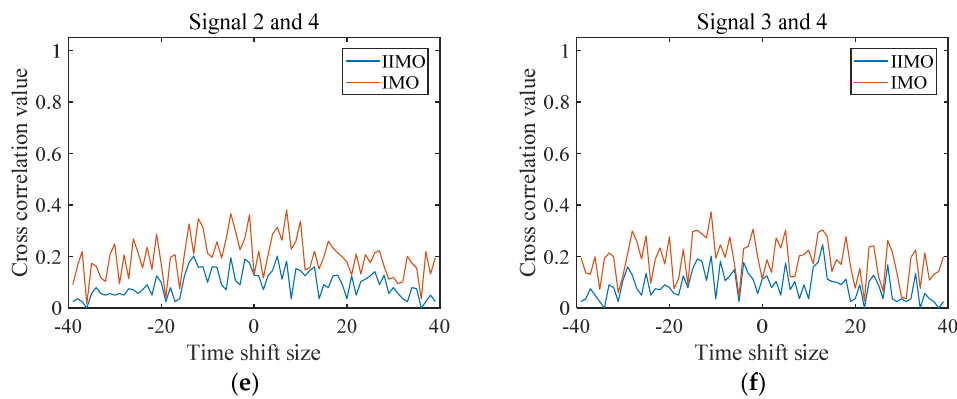
Figure 4. Cross-correlation values of polyphase codes obtained by IMO and IIMO under L = 4 and N = 40 on ( a ) between signal 1 and 2, ( b ) between signal 1 and 3, ( c ) between signal 1 and 4, ( d ) between signal 2 and 3, ( e ) between signal 2 and 4, ( f ) between signal 3 and 4.